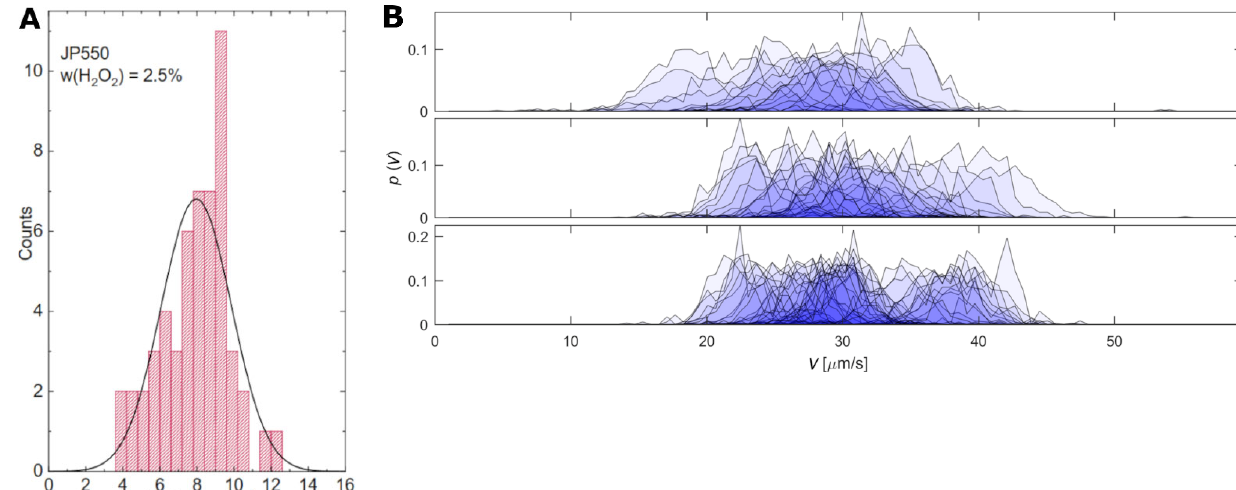
Figure 4. ( A ) Velocity distributions for TiO 2 on SiO 2 Janus ‐ type motors (d ~550 nm) in 2.5% H 2 O 2 ; ( B ) Velocity distribution for Pt on polystyrene Janus ‐ type motors (d ~2.8 μ m) in 0.1% (top), 1.0% (center) and 3.0% (bottom) H 2 O 2 ; (Obs.: ( A ) is built using the average speed of individual motors while ( B ) shows experimental velocity distributions for ~30 individual micromotors). Figures reproduced with permission from Ref. [42] (panel ( A )) and Ref. [43] (panel ( B )).